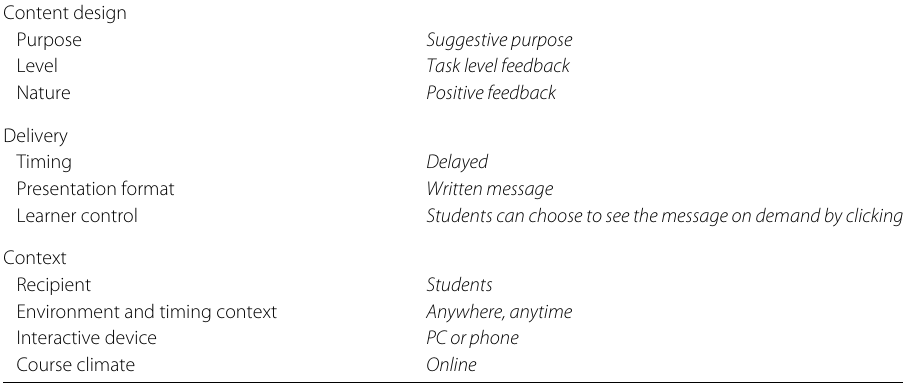
Table 3 Adaptive feedback design (instantiated from Serral et al.